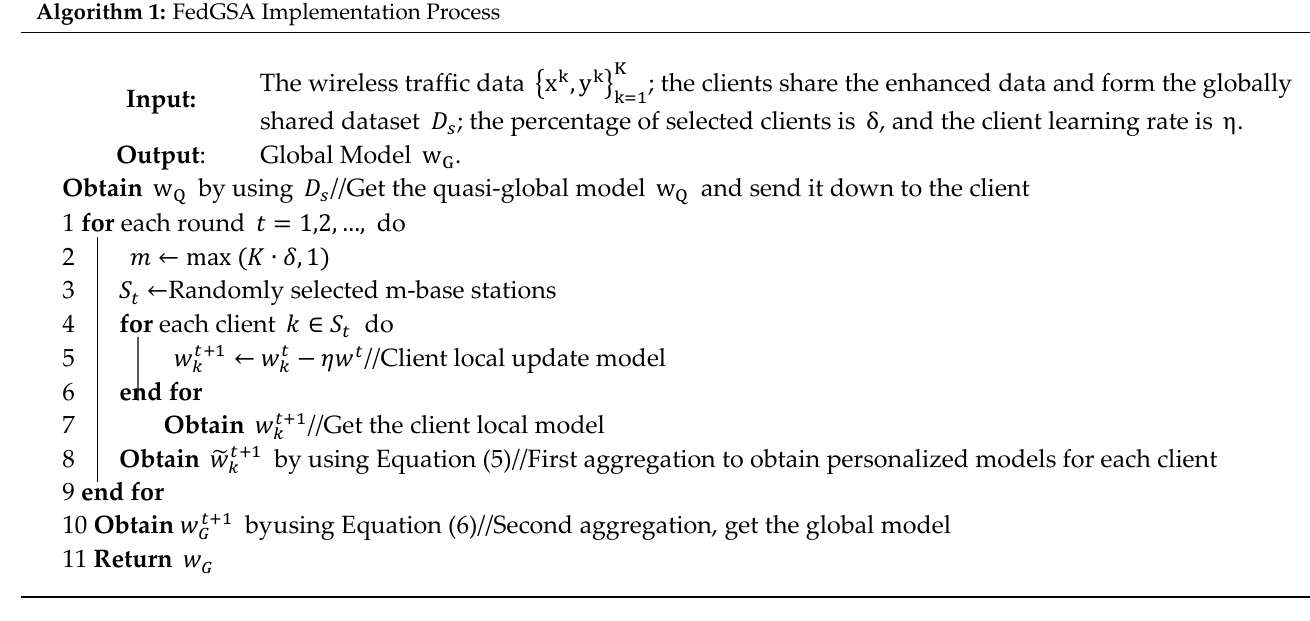
Algorithm 1: FedGSA Implementation